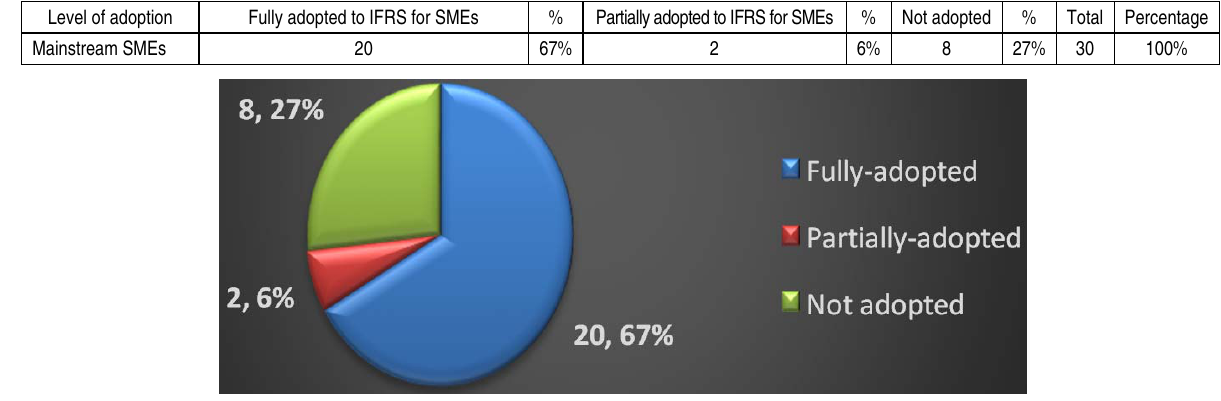
Fig. 3. Level of adoption of IFRS for